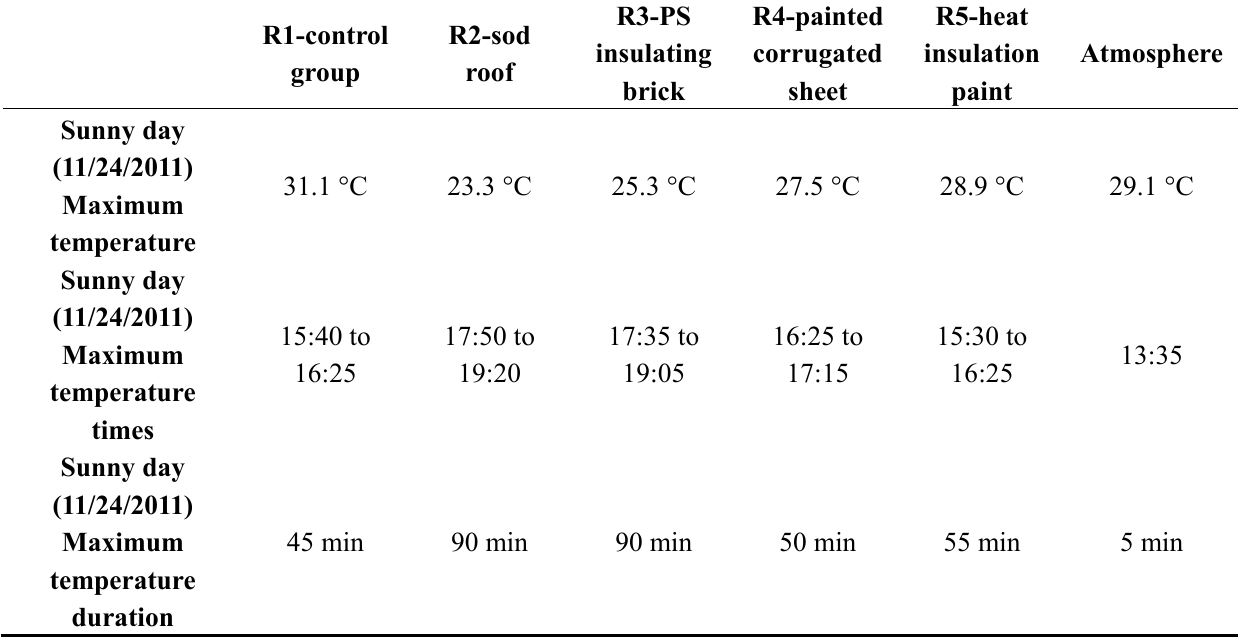
Table 3. Maximum temperature times inside simulated roof concrete